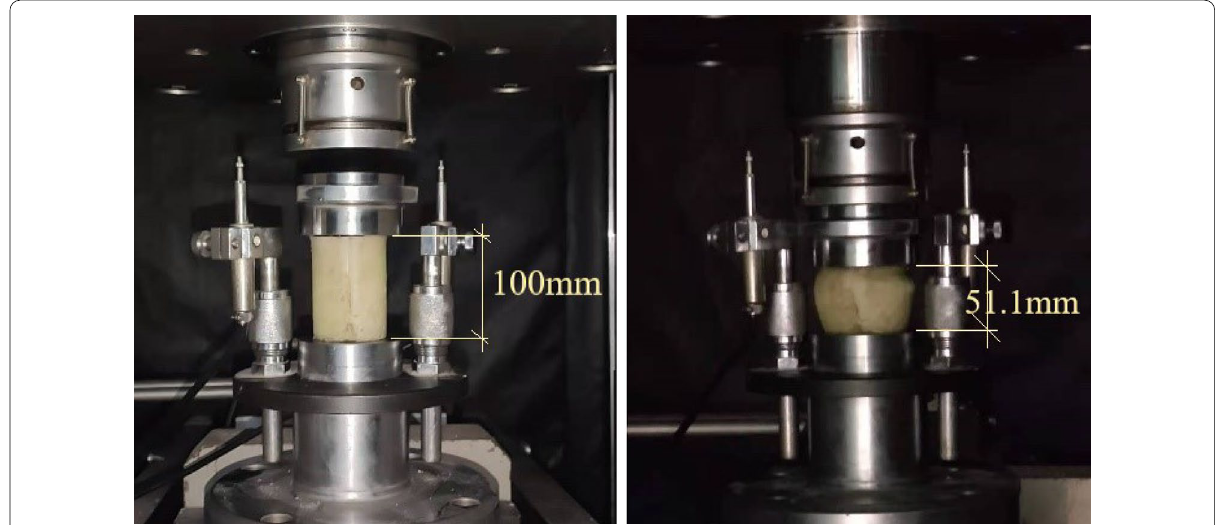
Fig. 7 Morphology of the granular PCL cylindrical sample before and after